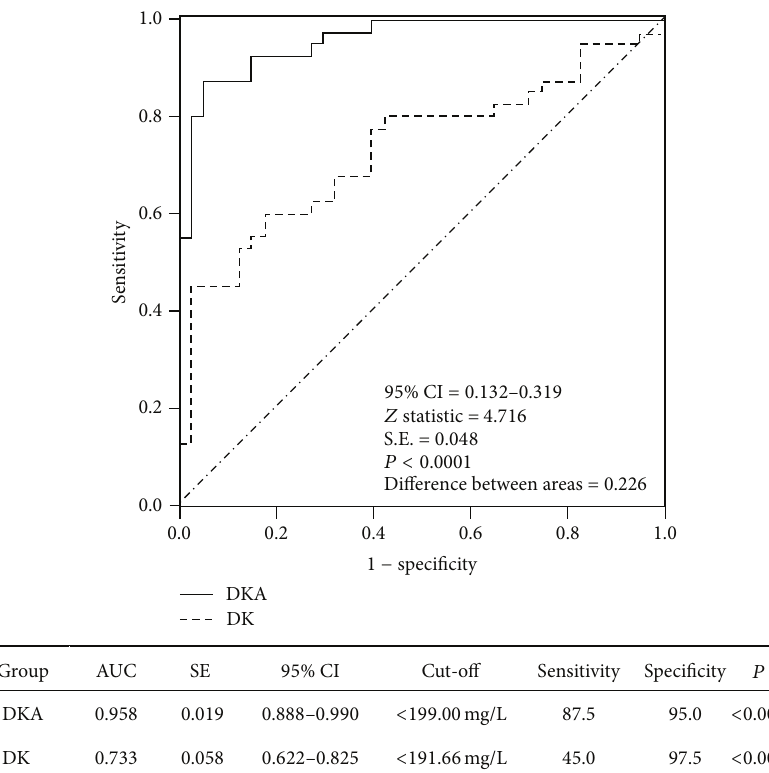
Figure 2: The ROC plots showed a significant difference in the ability of prealbumin levels to reflect DKA and DK. A comparison of the ROC plots between DKA and DK patients showed a significant difference ( 𝑃 < 0.0001